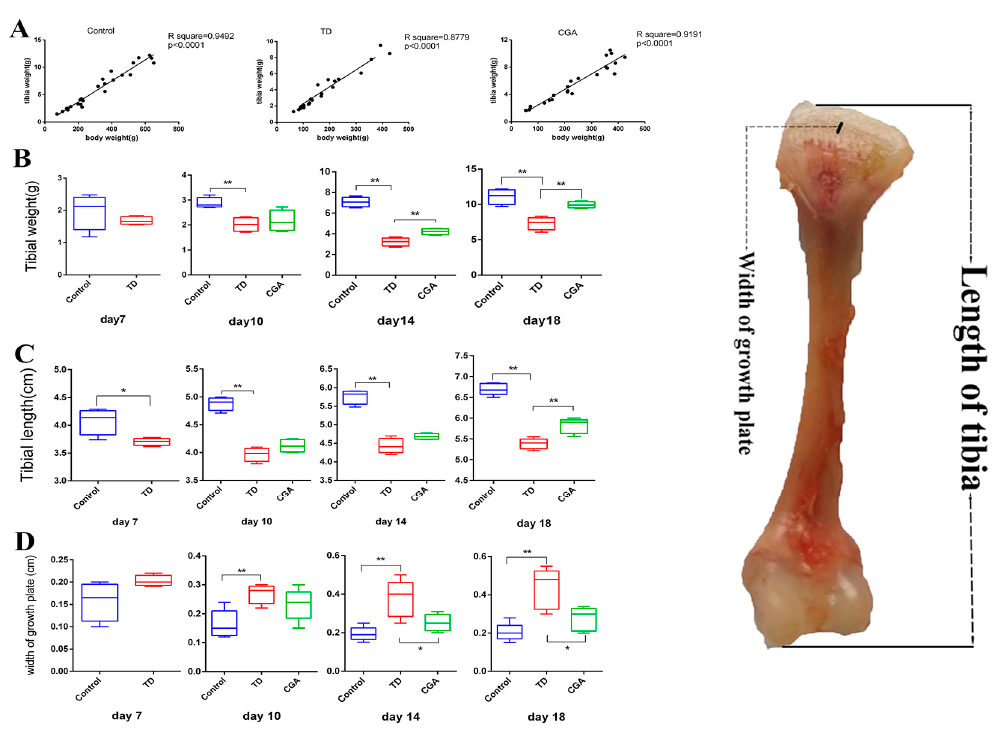
Figure 3. Chlorogenic acid improves tibial index of chickens. ( A ) Linear regression analysis of body weight and tibial weight among Control group, TD group and CGA group. ( B ) The tibial weight was recorded by using electronic balance at days 7, 10, 14 and 18. ( C – D ) The tibial length and width of growth plate were measured by using digital caliper at slaughter days 7, 10, 14 and 18. The data are expressed as means ± SD. * p < 0.05, ** p < 0.01.